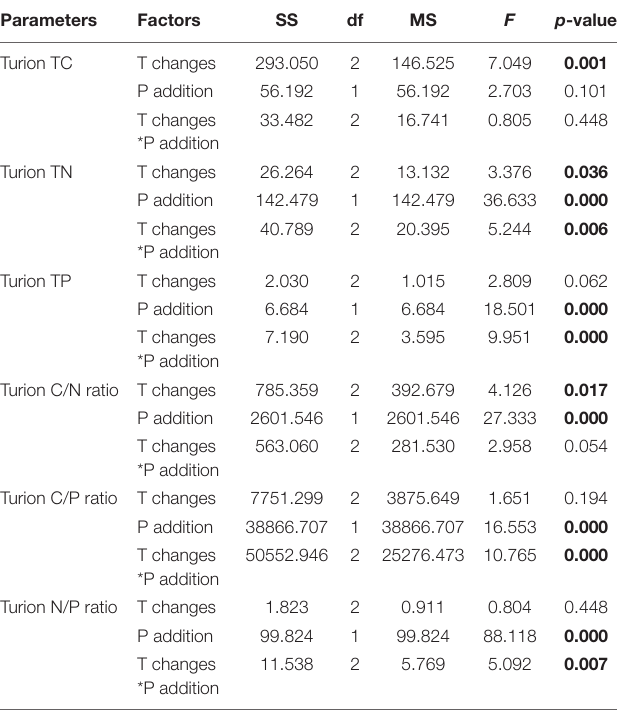
TABLE 3 | Effects of different temperature scenarios and phosphorus addition on the TC, TN, and TP contents and the C/N, C/P, and N/P ratios in P.crispus turions.